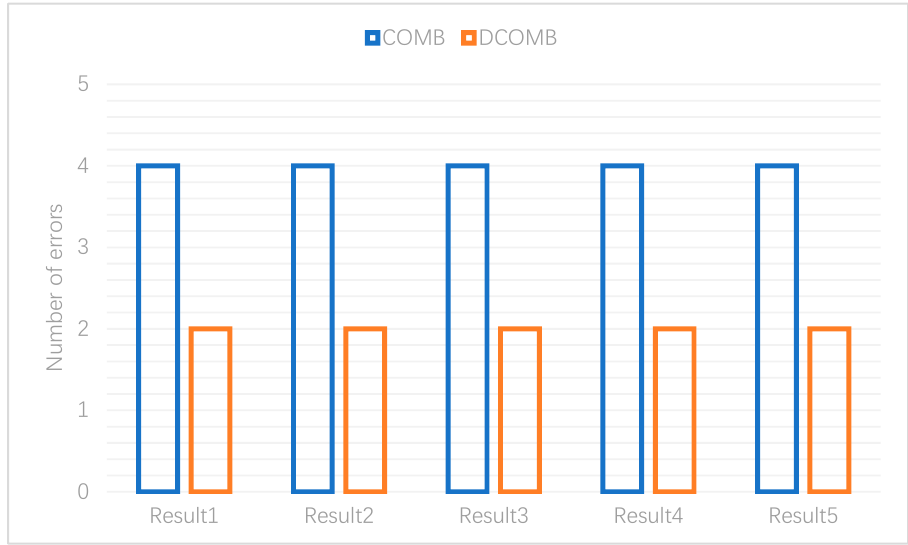
Figure 12. Number of errors.